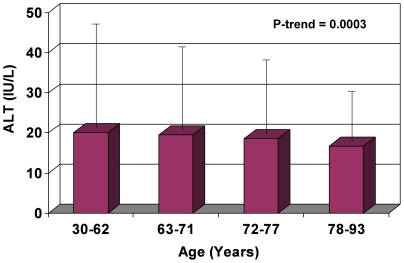
Effect of Age on ALT Values in Women (Mean and 95% Confidence Interval).In women, mean ALT (bars) and 95th percentile cutoff ranges (extension lines) both decrease with rising age.